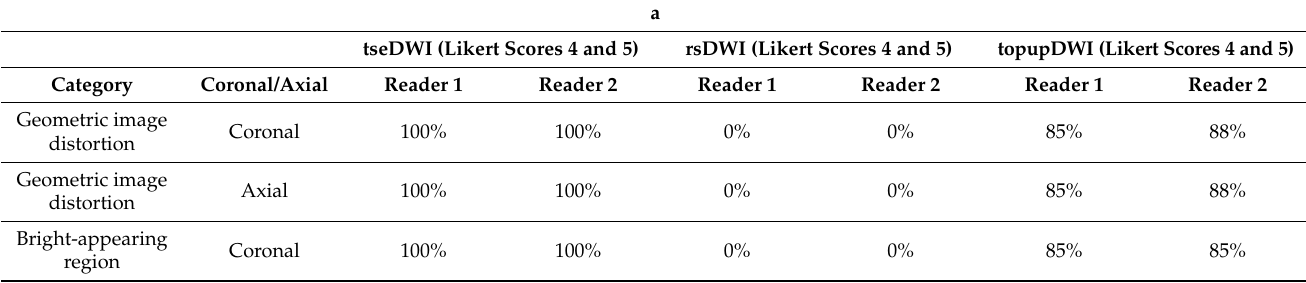
Table 2. a. Likert score evaluation (categories 1–5) per reader. b. Mean differences between readers 1 and 2 of Likert score evaluation (categories